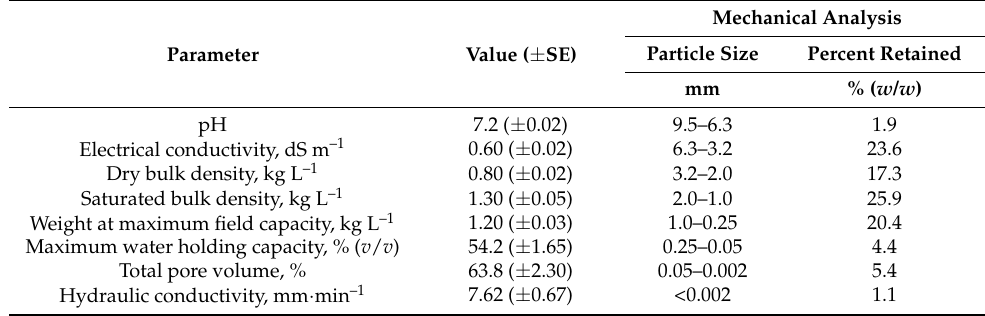
Table 1. Physical and chemical properties of the substrate, which comprised 65% pumice, 15% thermally treated atta- pulgite clay, 15% grape marc compost, and 5% clinoptilolite zeolite by volume. Values represent the mean values of three replications wherever the standard error is provided (±SE).